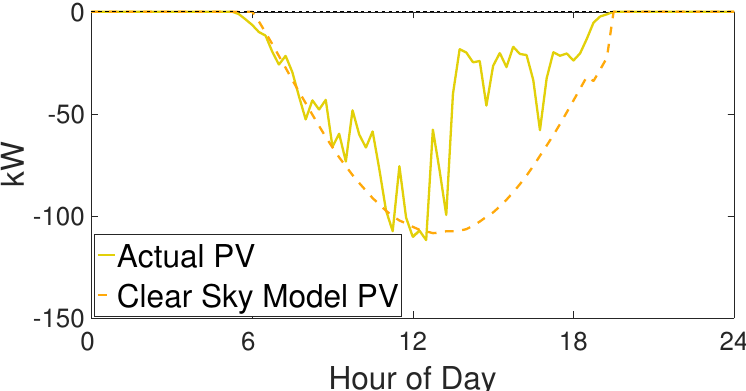
Figure 6. A comparison between actual PV power availability (solid line) and the power predicted by the clear sky model (dashed line) for a simulated day with low solar irradiance (1 July 2015).